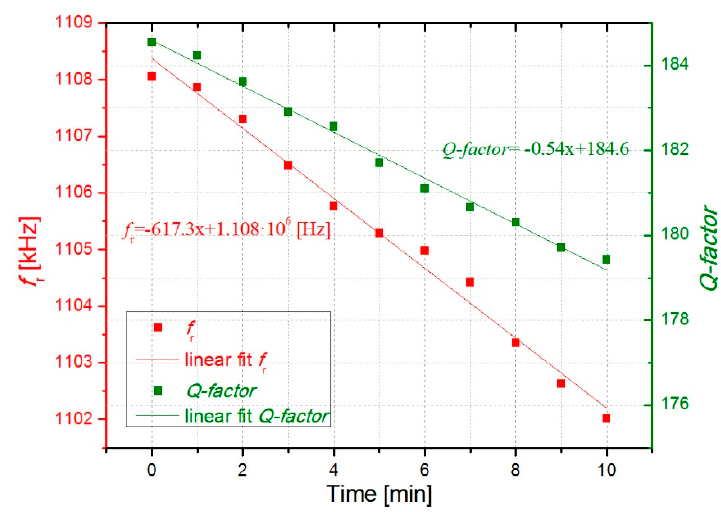
Figure 6. Open loop measurement showing the evolution of the resonant parameters with the deposition of cigarette particles for 10 minutes.